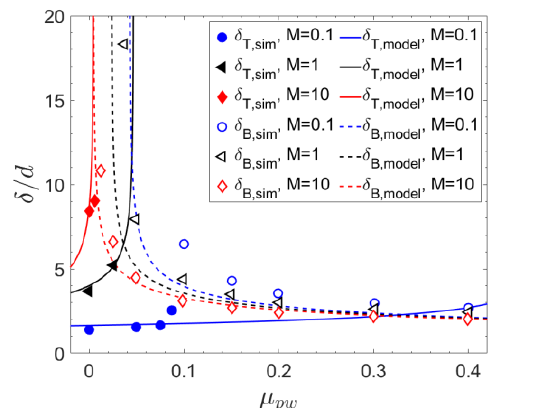
Fig. 2. Shear zone width versus lateral wall friction coefficient with various load parameter M =0.1,1,10. The subscripts T and B denote the top wall and the bottom wall, respectively.